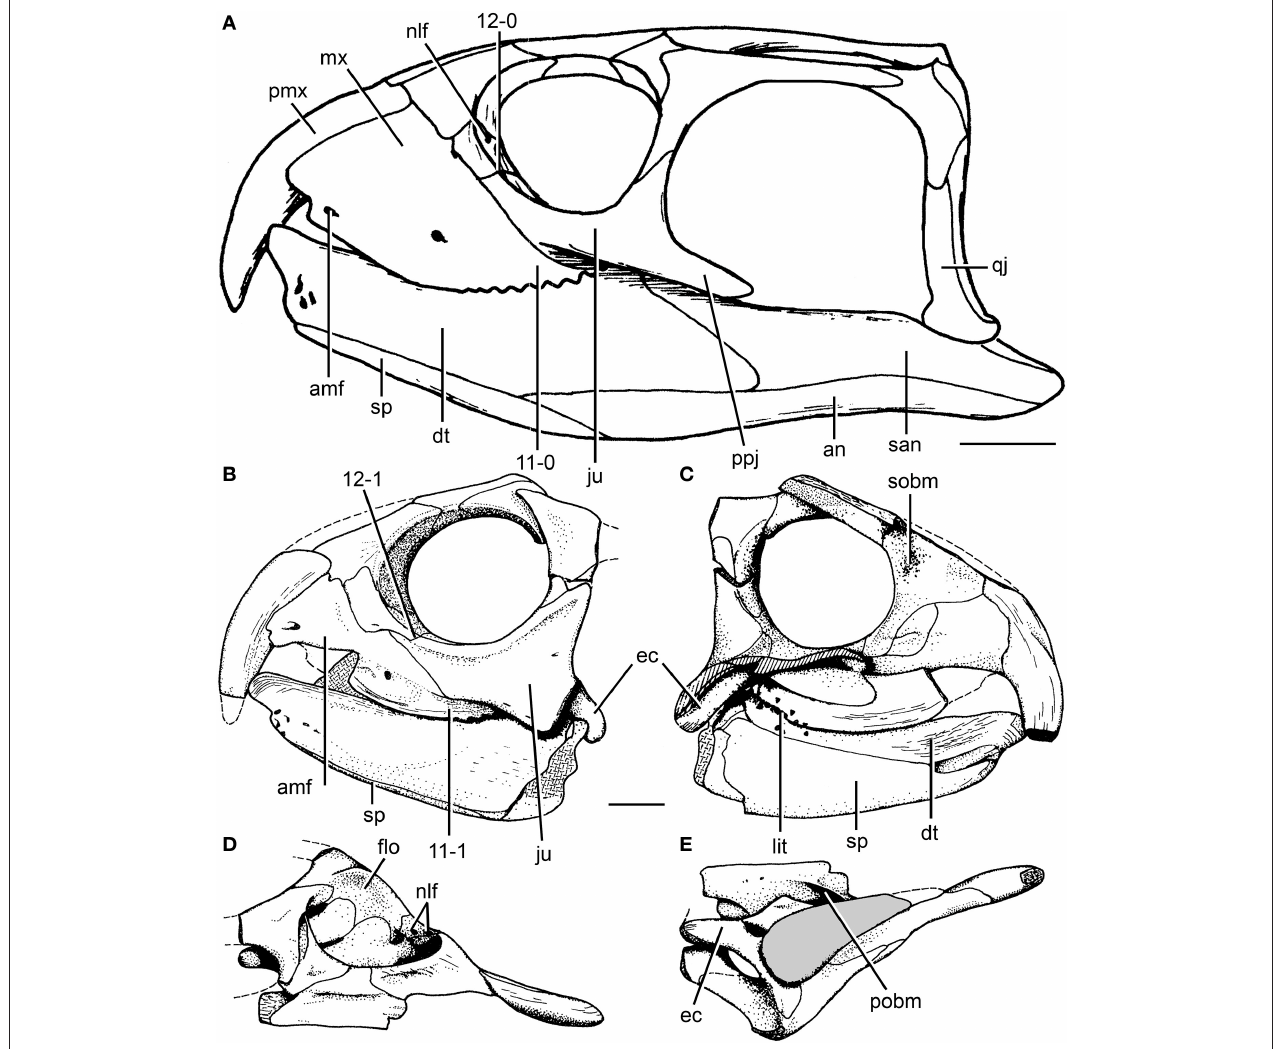
FIGURE 6 | Cranial reconstruction of Rhynchosaurus articeps and drawings of Langeronyx brodiei . R. articeps cranial reconstruction in left lateral view (A) and drawings of L. brodiei (WARMS G6097/1 and NHMUK PV R8495, holotype) in left lateral (B) , left medial (C), dorsal (D) , and ventral (E) views. Numbers indicate character-states synapomorphic of Langeronyx and rhynchosaurids to the exclusion of stenaulorhynchines and R. articeps . Abbreviations: amf, anterior maxillary foramen; an, angular; dt, dentary; ec, ectopterygoid; ju, jugal; flo, floor of the orbit; lit, lingual teeth; mx, maxilla; nlf, naso-lacrimal foramina; pmx, premaxilla; pobm, primary olfactory bulb mold; ppj, posterior process of the jugal; qj, quadratojugal; san, surangular; sobm, secondary olfactory bulb mold; sp, splenial. Scale bars equal 1cm. (A,E) modified from and (B-D) taken from Benton